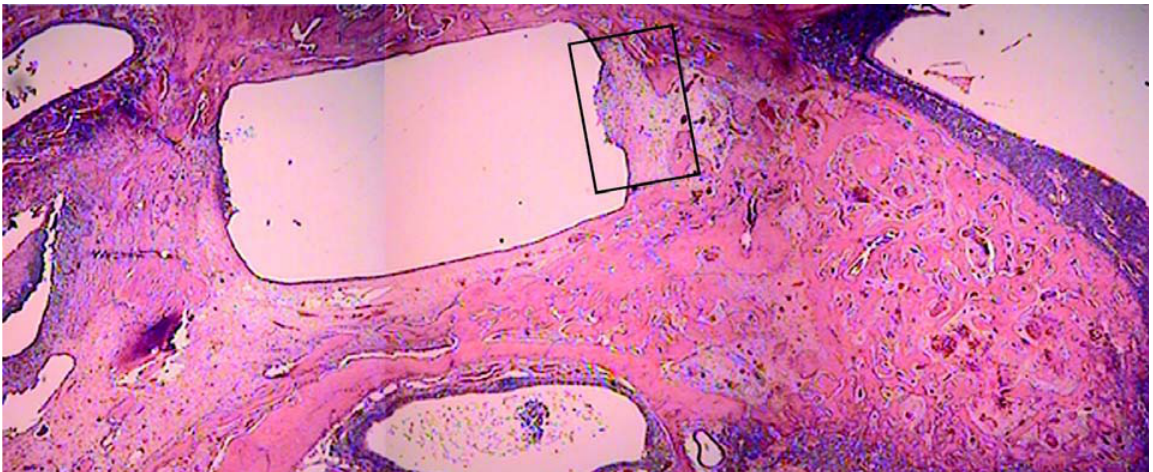
FIGURE 1- Histological section showing the tooth socket containing a polyethylene tube at the middle third. Note the area examined histologically TABLE 1- Results of variables inflammatory infiltrate and presence and location of bone tissue formation